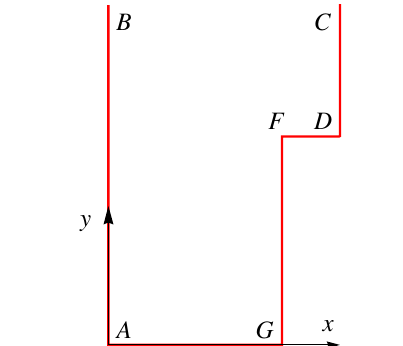
FIG. 3. The domain of solution of Eq. (7) is bounded by the red line (the letters along the line establish the correspondence with the area ABCDFG depicted in Fig. 2). Also shown is the local coordinate system x , y with the origin located at point